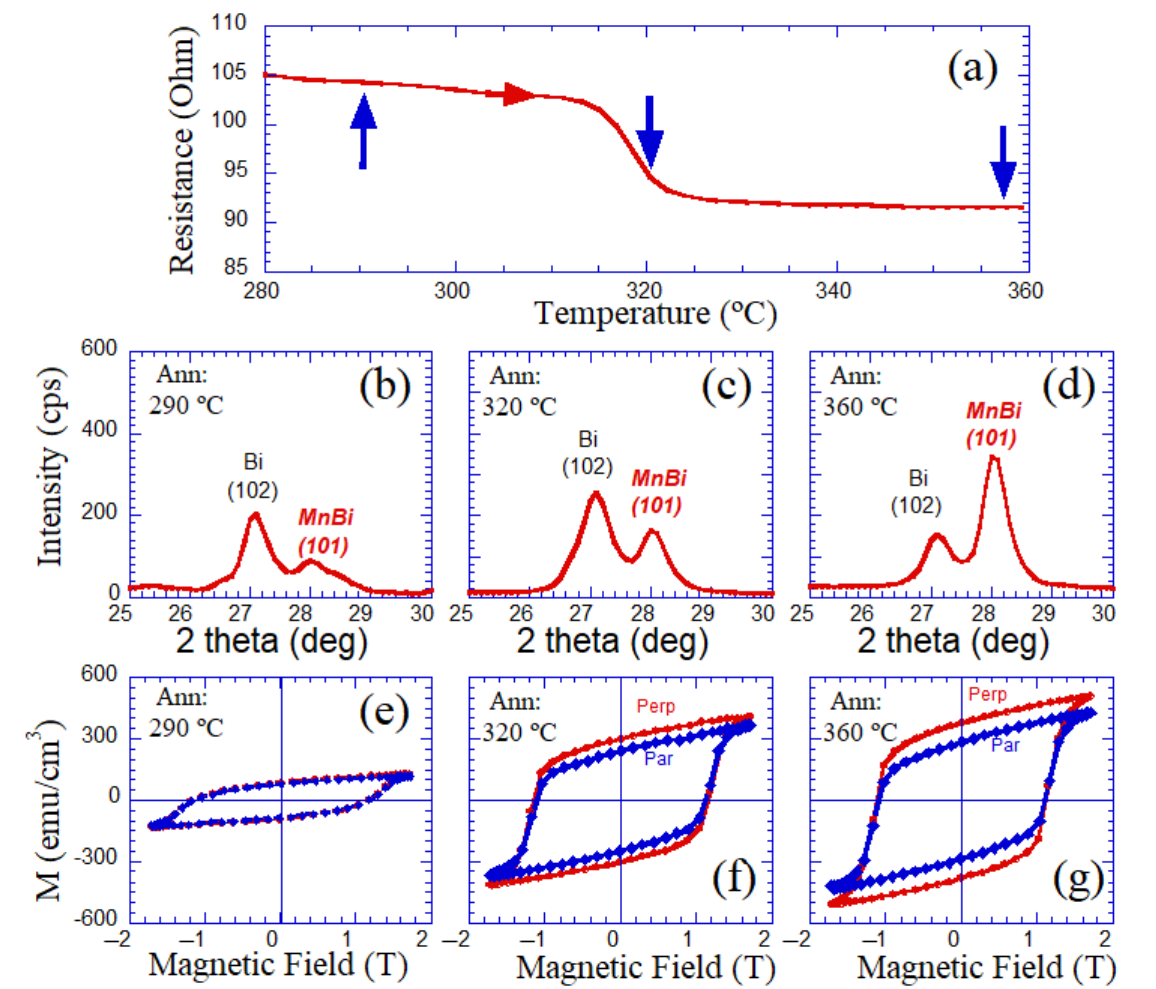
Figure 4. Resistance as a function of the temperature of the Mn(60%)Bi(40%) sample ( a ). The blue arrows over the resistance curve indicate the annealing temperatures. The red arrow indicates that the resistance was measured on increasing the temperature. X-ray diffraction patterns ( b – d ) and room-temperature magnetic hysteresis loops ( e – g ) of the 290, 320 and 360 °C annealed Mn(60%)Bi(40%) samples, respectively. Par and Perp indicate the parallel and perpendicular orien- tation of the magnetic field with respect to the film plane.